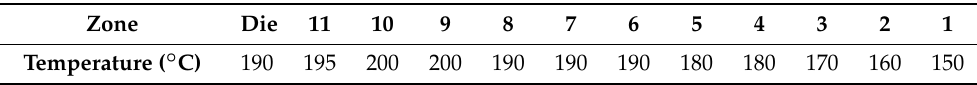
Table 1. Extrusion temperature profile for the preparation of